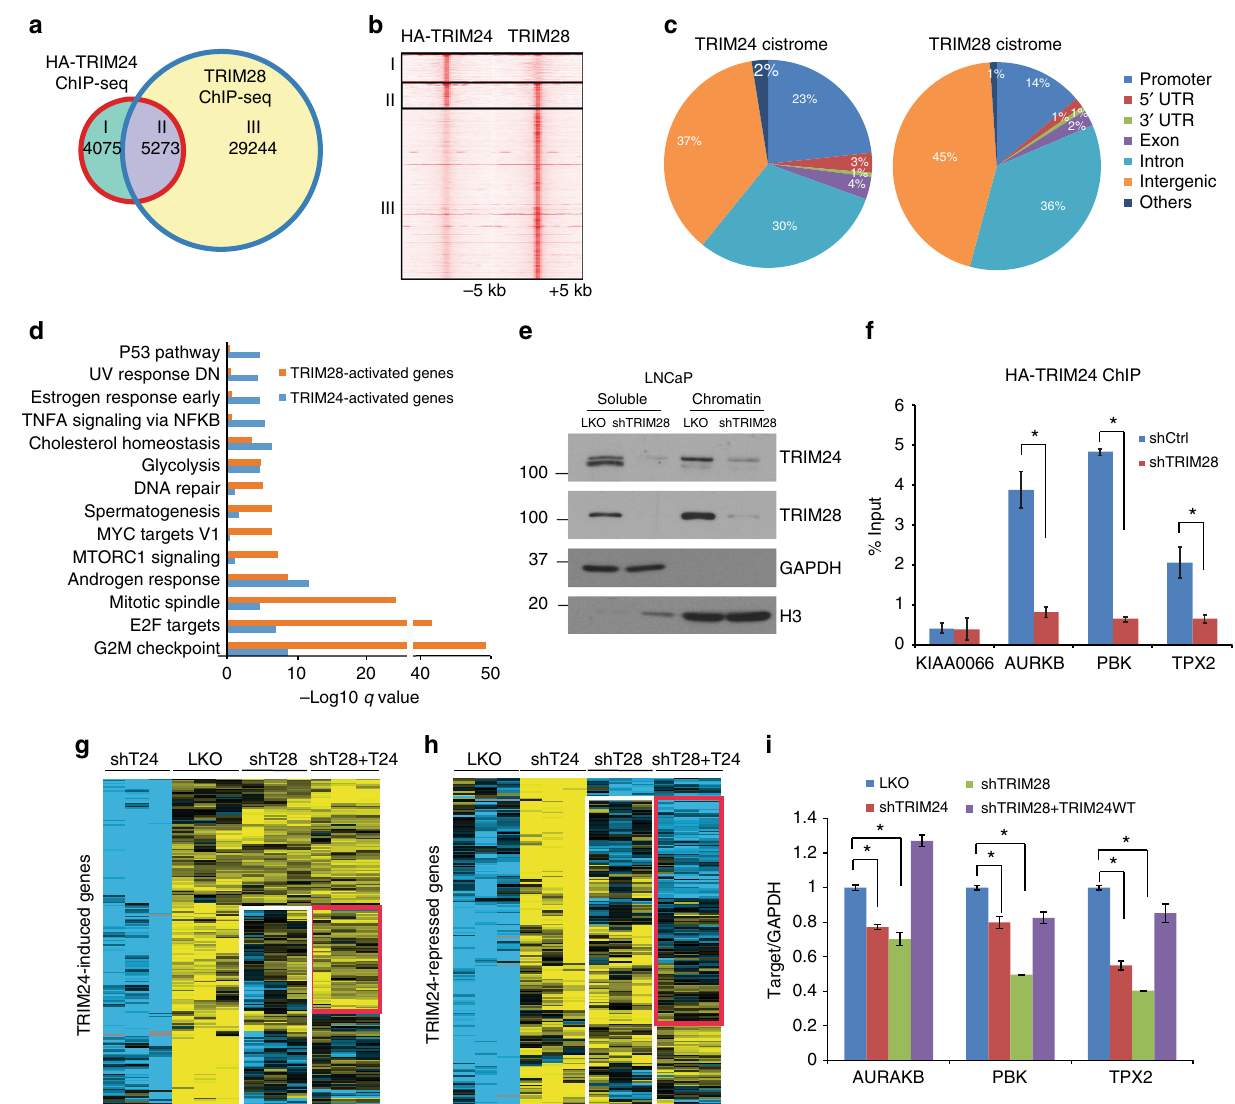
Fig. 4 TRIM28 enhances TRIM24 transcriptional program. a , b TRIM28 co-occupies TRIM24 binding sites. LNCaP cells stably expressing HA-tagged TRIM24 were hormone-starved for 3 days, stimulated with 10 nM R1881 for 16 h, and then subjected to TRIM28 and HA (TRIM24) ChIP-seq. Venn diagram ( a ) and Heatmap ( b ) showing overlapping of TRIM28 and TRIM24 binding sites. c Genomic distribution of the HA-TRIM24 and TRIM28-speci fi c cistromes. Genomic elements were de fi ned as promoters (2 kb upstream to 2 kb downstream of a TSS — transcription start site), 5 ′ UTR, 3 ′ UTR, coding exons, introns, distal intergenic regions, and others. d HALLMARK gene sets enriched by TRIM28- or TRIM24-activated genes. TRIM24- or TRIM28- activated genes were determined by microarray pro fi ling of LNCaP cells expressing pLKO, shTRIM24 or shTRIM28 in the presence of R1881 and subsequently subjected to GSEA analysis. The FDR q- values of enriched GO terms are indicated on the x-axis. e TRIM28 stabilizes